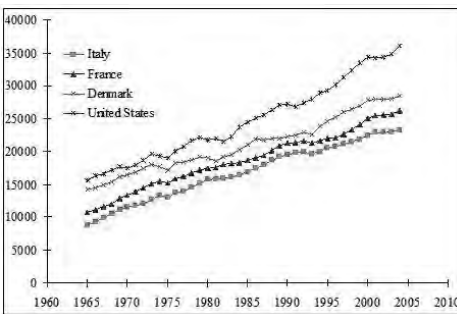
Figure 2: Annual Per Capita GDP of Four Countries (in PPP $ Purchasing Power Pa- rity Dollars) 17